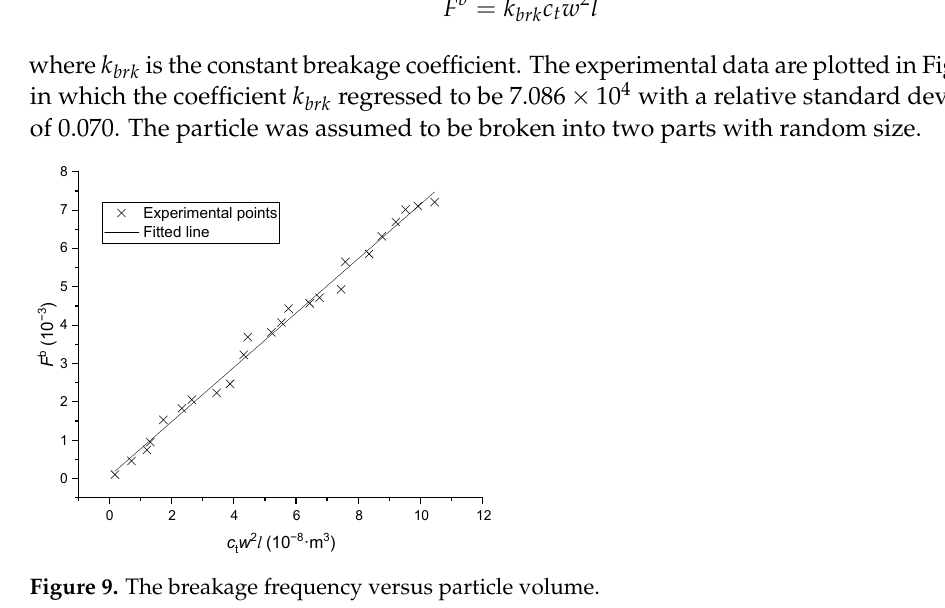
Figure 9. The breakage frequency versus particle volume.